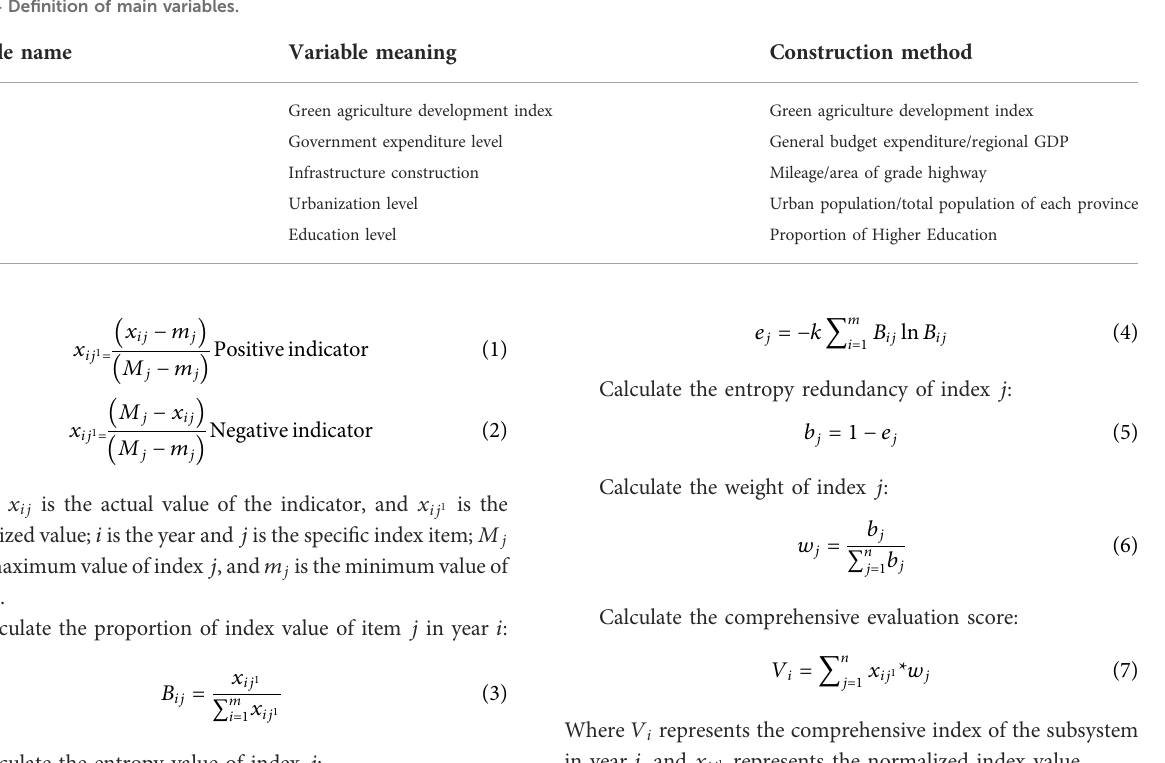
TABLE 4 De fi nition of main